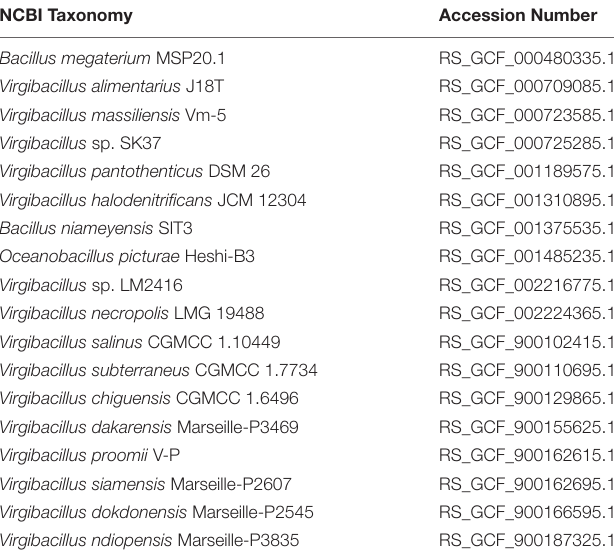
TABLE 1 | Accession numbers of genomes used in the GTDB analysis.